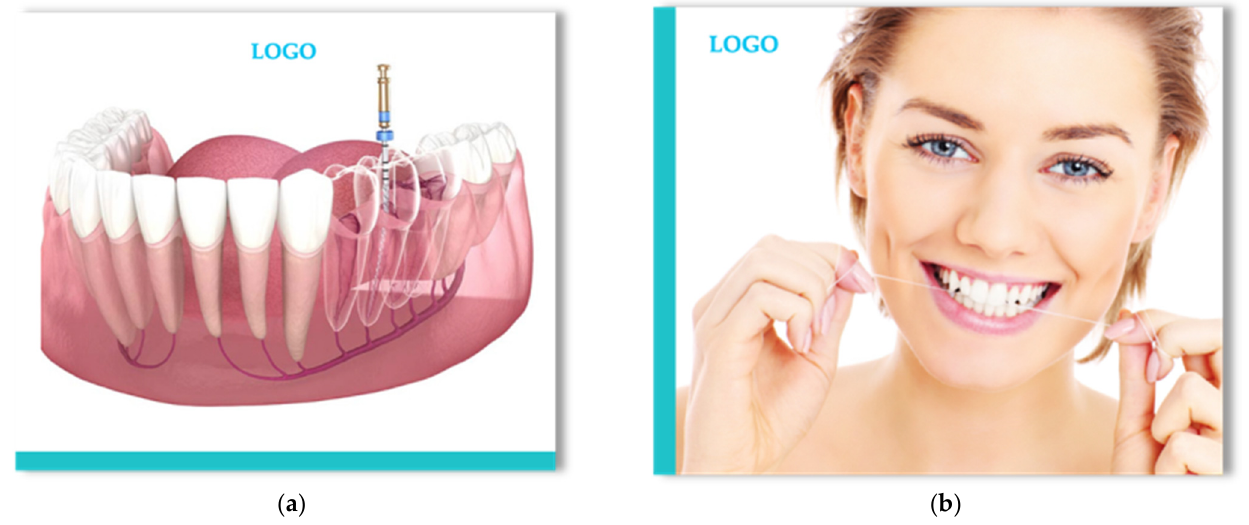
Figure 1. Campaign creative components: ( a ) mouth details, ( b ) woman smiling.